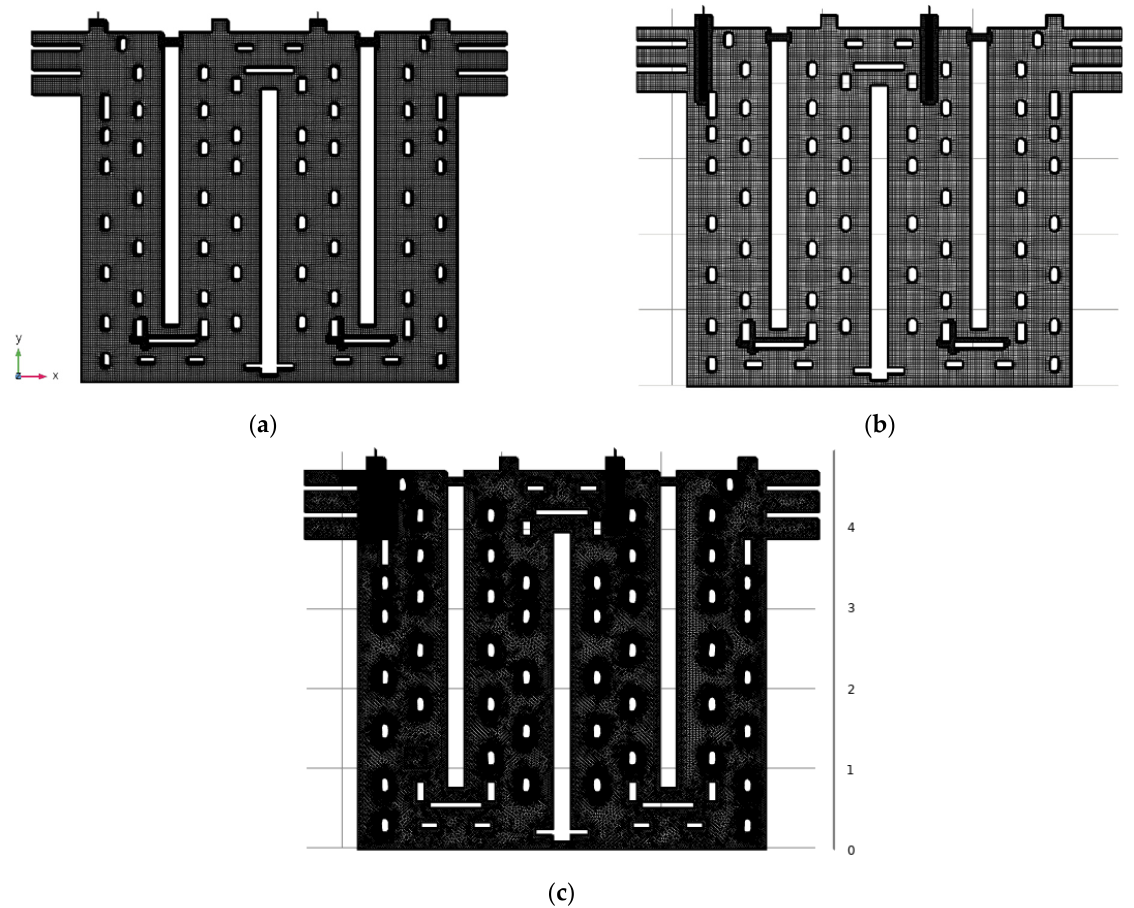
Figure 3. Illustration of the meshes created using the two geometries: ( a ) Mesh 1 generated using cfMesh and geometry 1; ( b ) Mesh 2 generated using cfMesh and geometry 2; ( c ) Mesh 3 generated using COMSOL Multiphysics and geometry 2. Table 3. Description of 3D geometry and the three meshes.